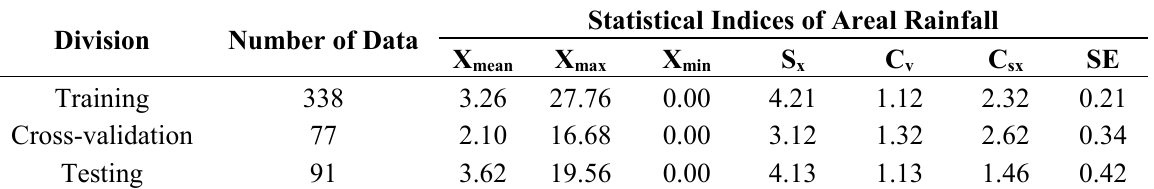
Table 1. Statistical indices of areal rainfall data using the kriging method.